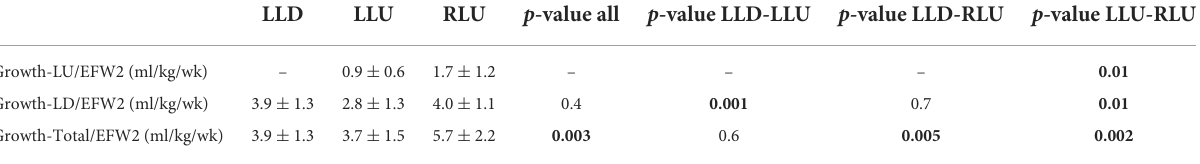
TABLE 3 Greater liver growth in right-sided CDH compared to left.